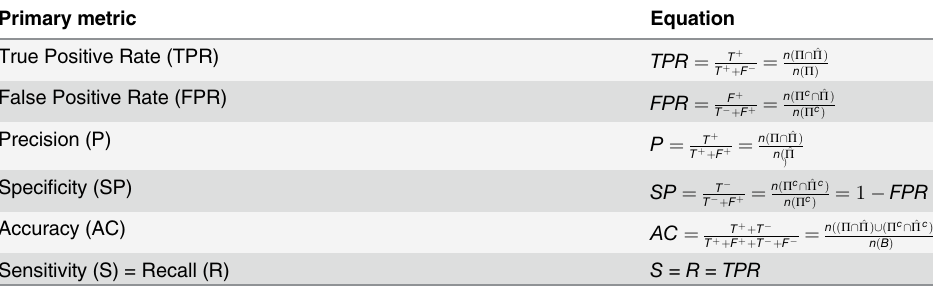
Table 2. Primary metrics of the confusion